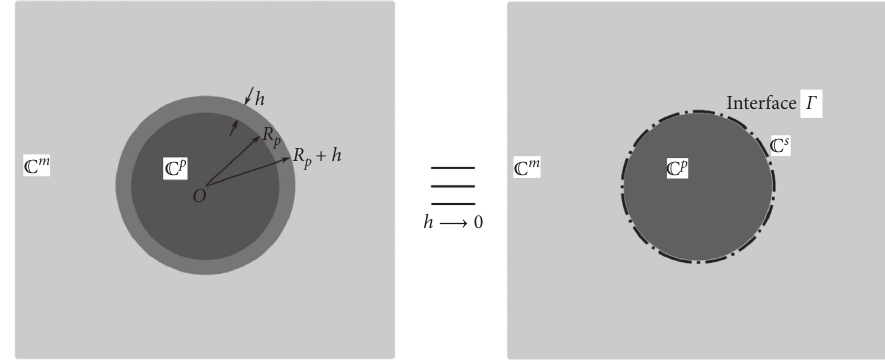
Figure 1: Microstructure of heterogeneous material.